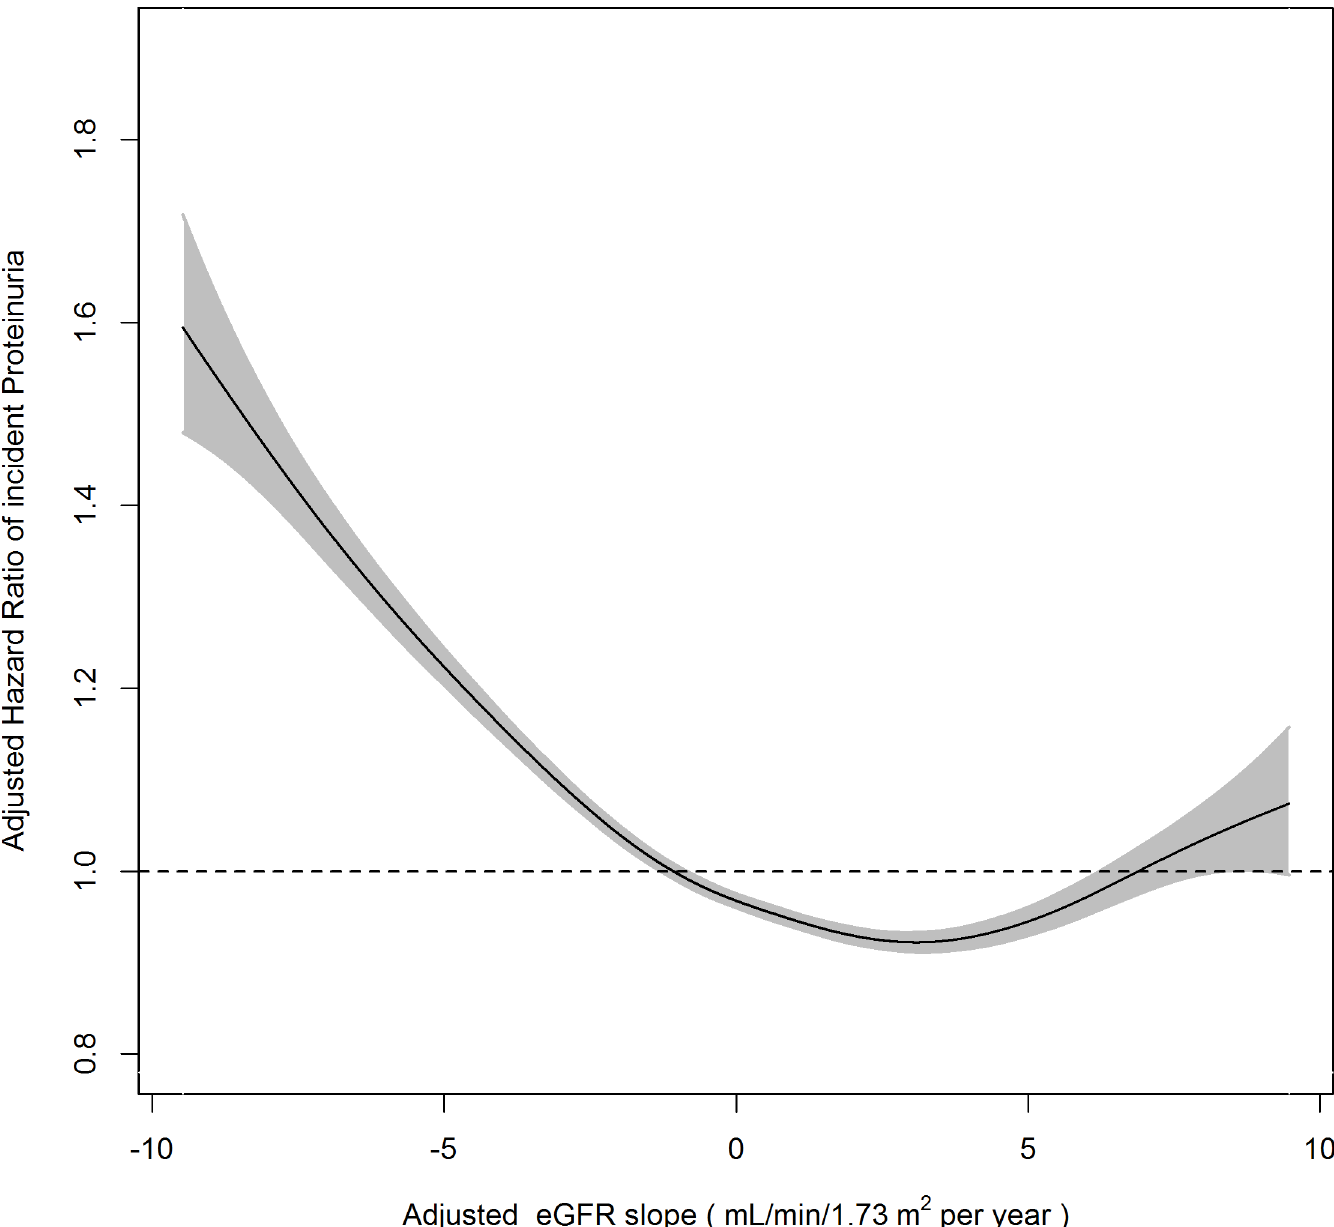
Fig 2. A reverse J-shaped association between estimated glomerular filtration rate (eGFR) slope and the adjusted hazard ratio (aHR) for incident proteinuria. aHR was calculated with a Cox regression model adjusted for age, sex, smoking status, regular exercise, regular alcohol consumption, known history of diabetes and/or hypertension medication, body mass index, systolic blood pressure, fasting serum glucose, serum triglycerides, and serum high-density lipoprotein-cholesterol in subjects who had undergone health screening five or more times. The relationship between the eGFR slope and the aHR was evaluated with a generalized additive model. The shaded area represents the 95% confidence